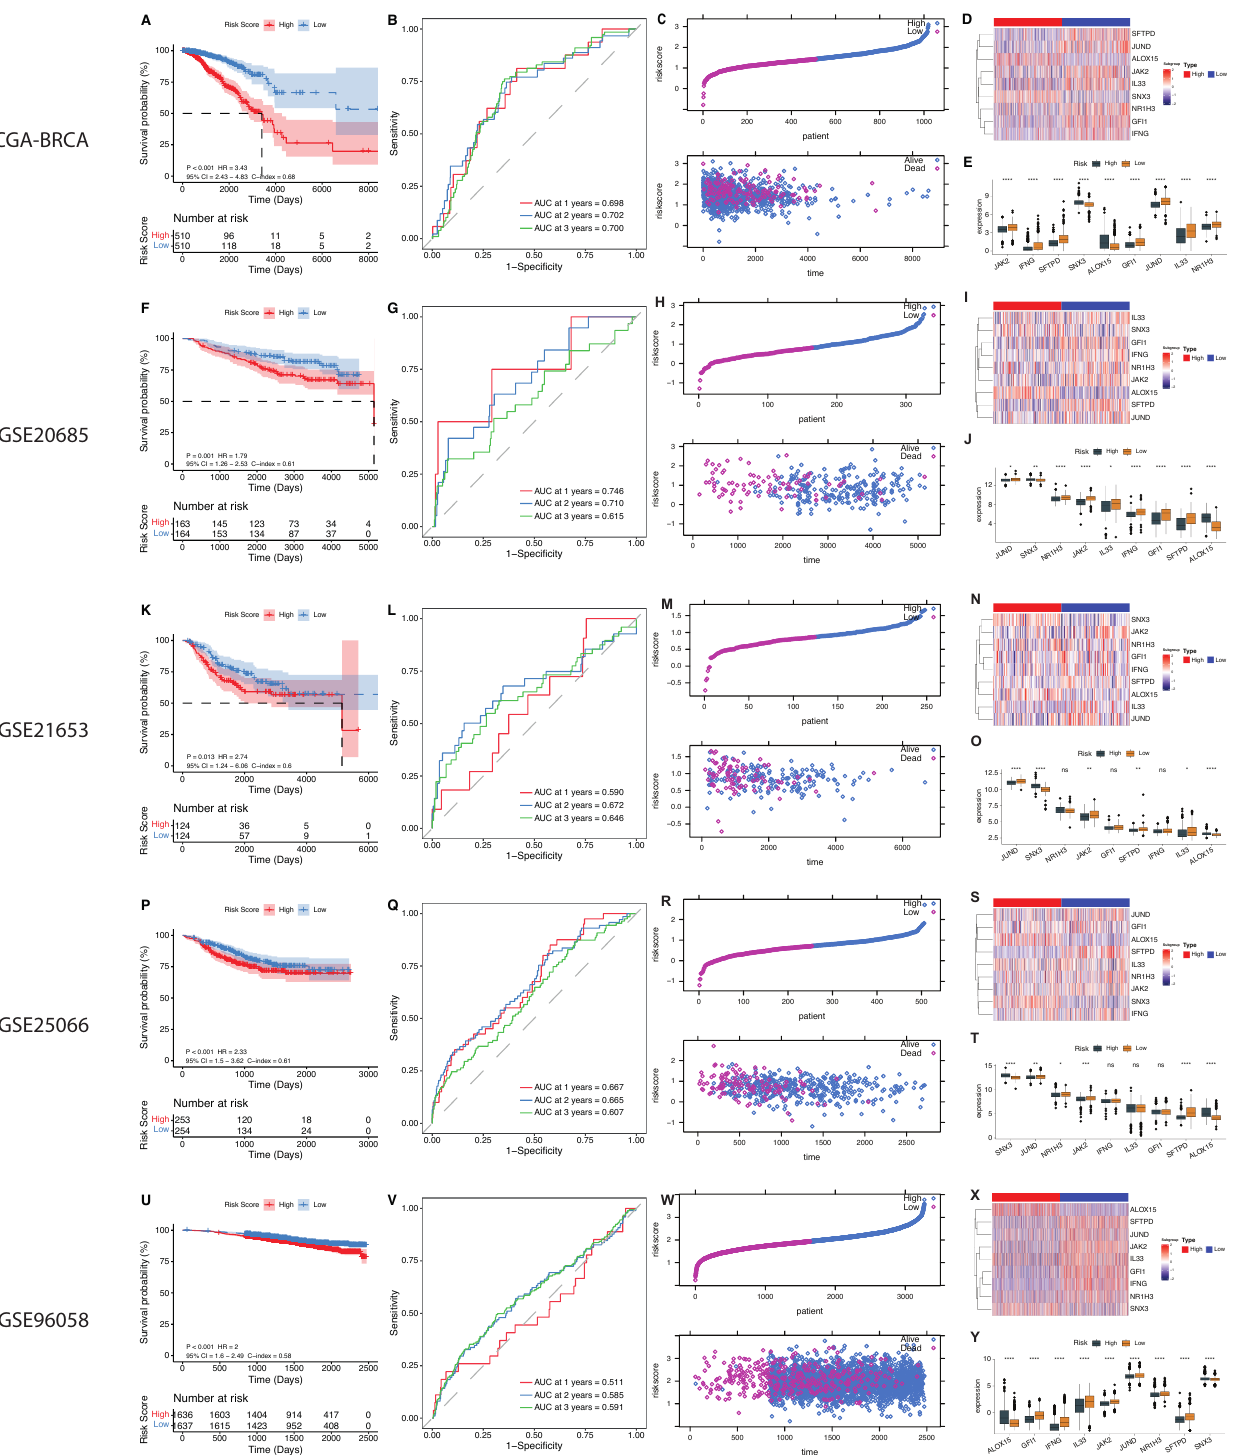
Figure 9. Identification of 9 genes with prognostic ability. ( A – E ) TCGA; ( F – J ), GSE20685; ( K – O ), GSE21653; ( P – T ), GSE25066; ( U – Y ), GSE96058; ( A , F , K , P , U ), OS analysis; ( B , G , L , Q , V ), 1, 2, and 3 year AUC; ( C , H , M , R , W ), sample risk core statistics (top), survival time and sample risk core statistics (bottom). ( D , I , N , S , X ) Expression heat map of 9 genes; ( E , J , O , T , Y ) expression difference between high and low-risk core groups of 9 genes. (* p < 0.05, ** p < 0.01, *** p < 0.001, **** p < 0.0001, and ns p value >